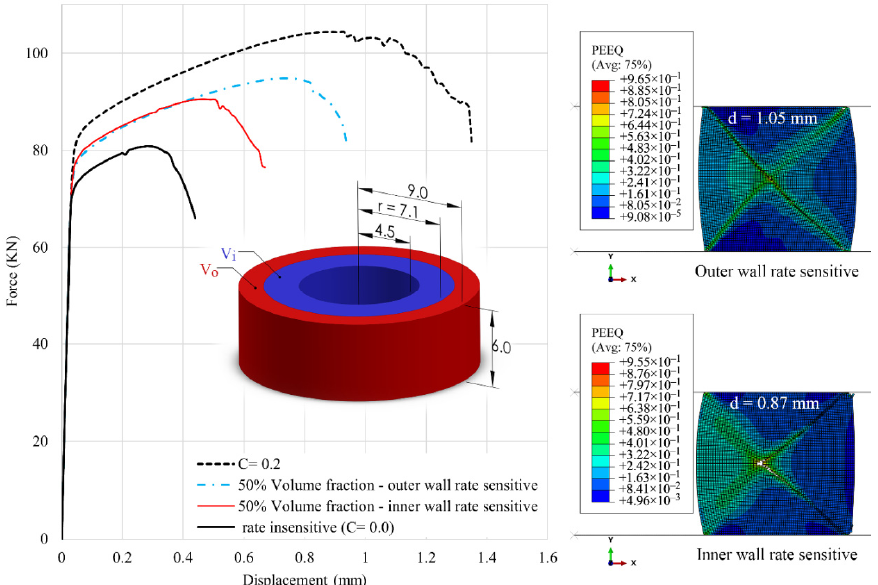
Figure 10. Effect of location of rate-sensitive material with 50% volume fraction on the f–d curves. On the right, the distribution of equivalent plastic strain is shown for the case of outer wall rate- sensitive at the displacement level of d = 1.05 mm, and for the case of inner wall rate-sensitive at the displacement level of d = 0.87 mm .